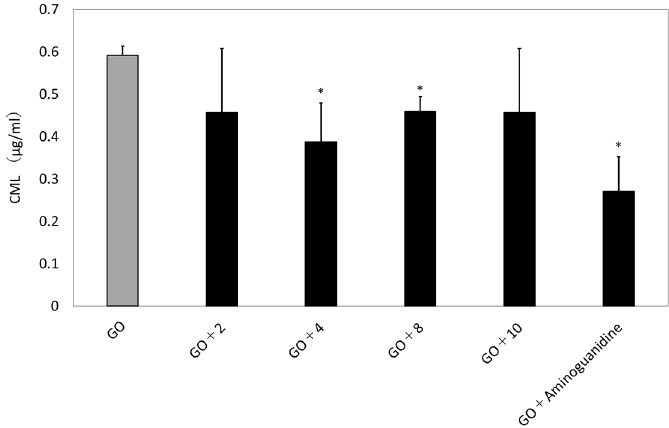
Figure 10. Amount of glycation end product (CML) formation with isolated compounds. n = 3. GO: Glyoxal (1.25 mM); aminoguanidine: positive control (1.5 mM); compounds 2 : chlorogenic acid, 4 : (2 E , 6 R )-2, 6-dimethyl-2,7-octadien-6-ol-1- O - β - D -glucopyranoside, 8: 5, 5 (cid:48) -diallyl-2,2 (cid:48) -diglucopyranosyl-3, 3 (cid:48) -dimethoxy diphenyl ether, 10: kaempferol 4 (cid:48) - O -glucopyranoside; sample concentration: 25 µ g/mL. The bars represent the mean + SD; * p < 0.05 versus GO; student t